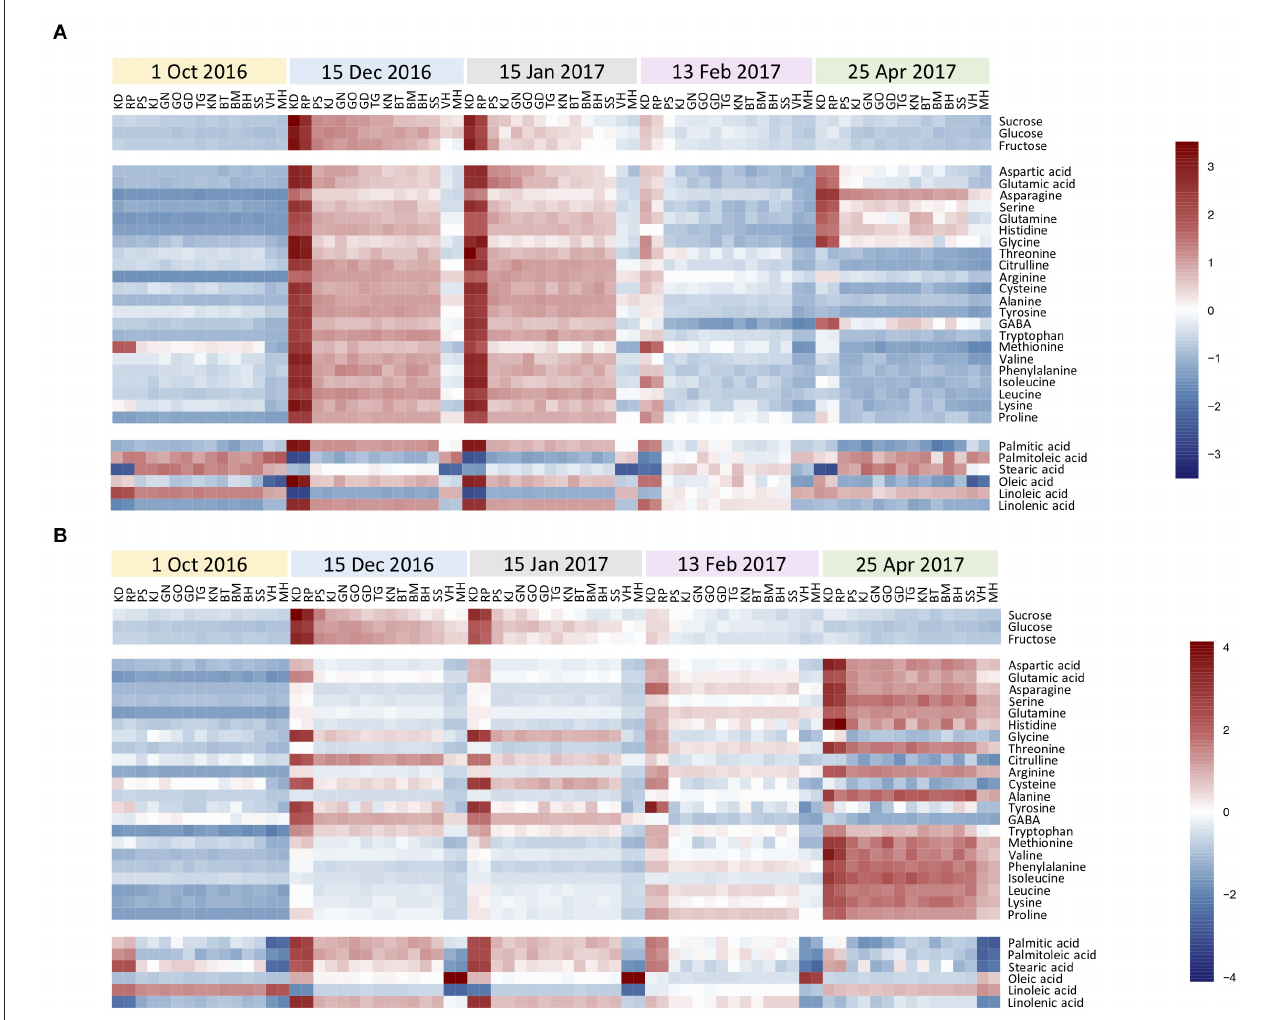
FIGURE 2 | The heatmaps for seasonal variation of primary metabolites in pomegranate stem (A) and bud (B) . The column represents each genotype (KD, RP, PS, KJ, TG, GO, GD, BT, KN, GN, BM, BH, SS, VH, and MH) at the specific time-point (1 October and 15 December 2016, 15 January, 13 February, and 25 April 2017). Each cell represents the mean values of three biological replicates of each metabolite. The color scales from blue (low) to red (high) and is proportional to the normalized values (expressed as log 2 ) of the concentration of each metabolite.